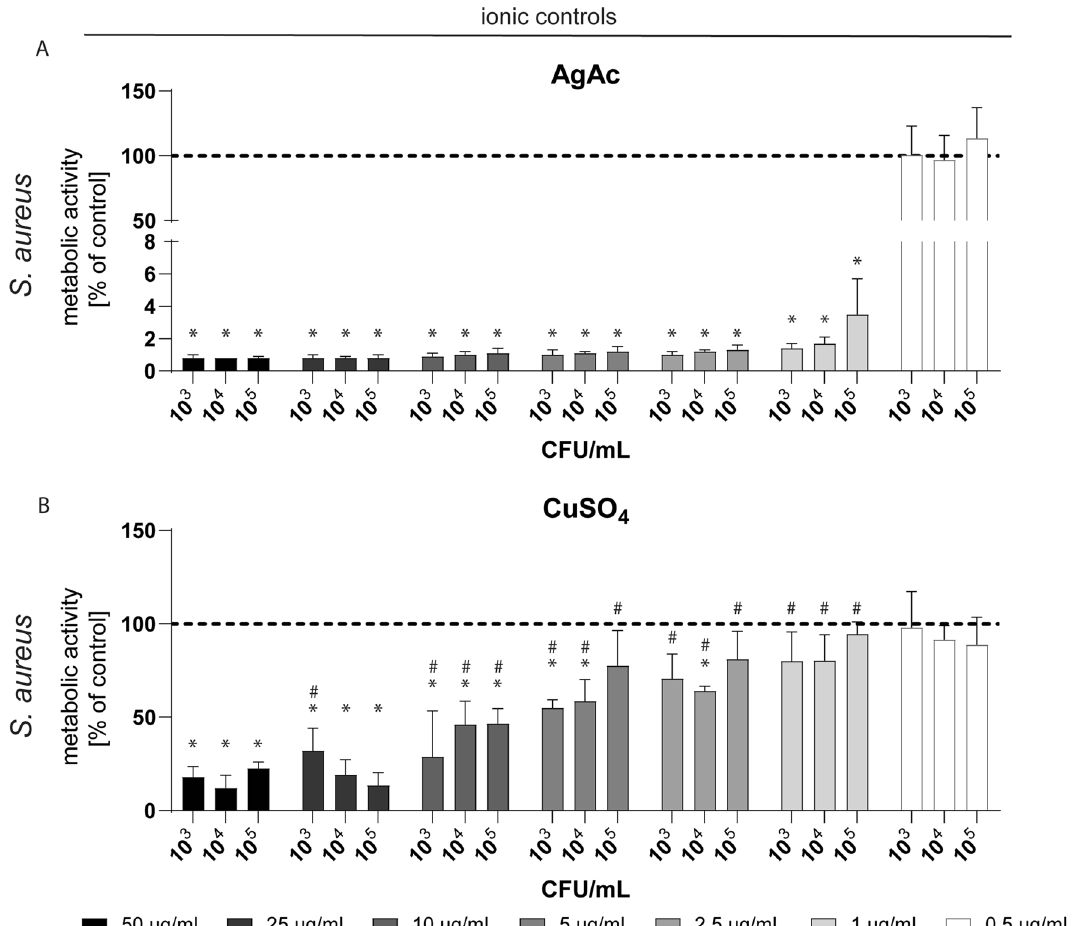
Figure 4. Quantitative analysis of the antibacterial activity of silver acetate (AgAc, panel A) and copper sulfate (CuSO 4 , panel B) solutions towards S. aureus (different bacterial concentrations) performed by the AlamarBlue assay. Data are expressed as mean ± SD of at least three independent experiments and given as the percentage of untreated bacteria (no exposure). Asterisks (*) indicate significant differences (* p ≤ 0.05) compared to the untreated control; hash marks indicate significant differences (* p ≤ 0.05) between AgAc and CuSO 4